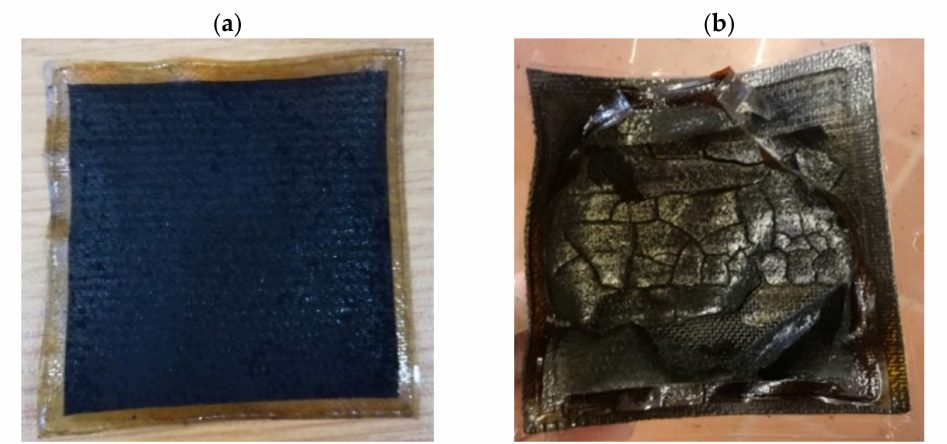
Figure 16. Digital images of polybenzimidazole (PBI) membranes before and after ammonia exposure: ( a ) fresh membrane (before) and ( b ) cracked membrane